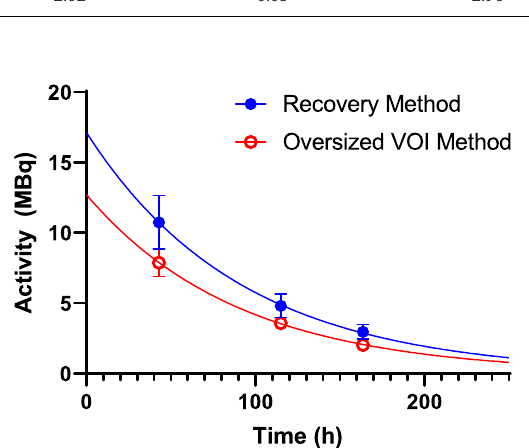
Fig. 12 Time activity curve for bone metastases in [ 131 I]mIBG radionuclide therapy